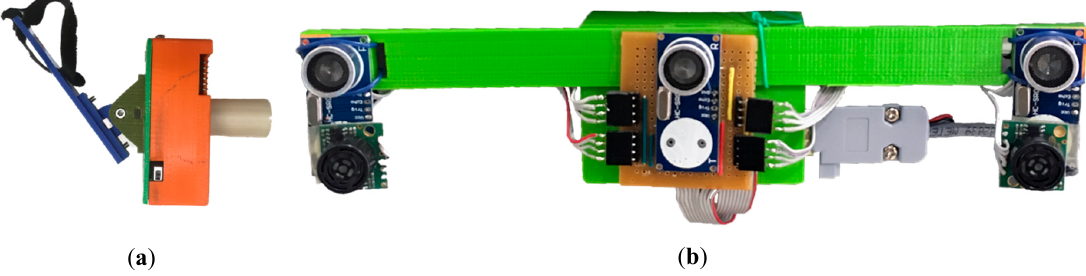
Figure 8. ( a ) Ultrasonic beacon for AP, ( b ) ultrasonic tethering receiver for powered